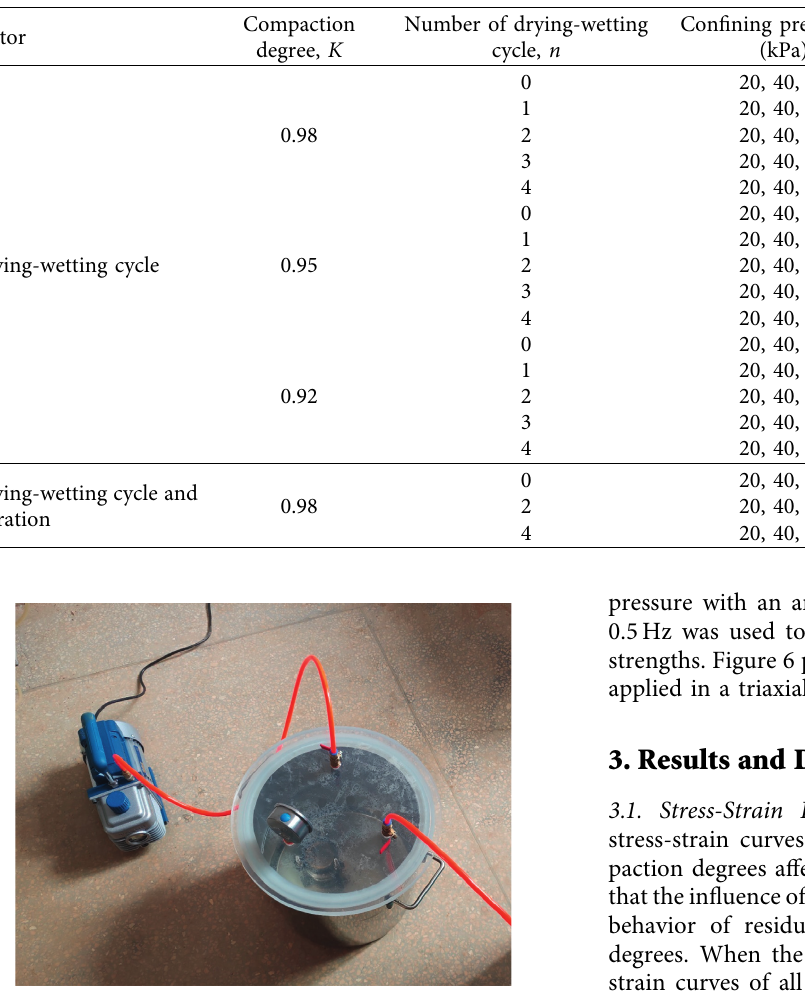
Table 3: Test schemes.